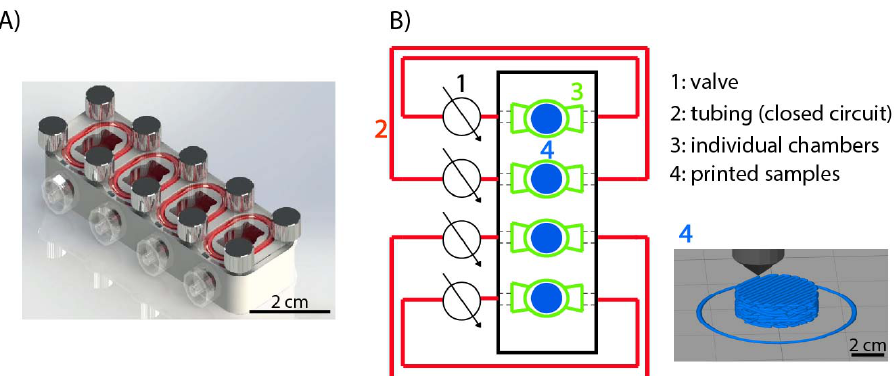
Figure 2. In-house fabricated bioreactor used for study of degradation under static and dynamic conditions. ( A ) Render of the bioreactor used in this study. ( B ) Simplified scheme of the bioreactor where the elements that compose the bioreactor system are: (1) valves, (2) tubing system which allows four different closed circuits, (3) bioreactor individual chambers, (4) sample along with a schematic of a 3D printed